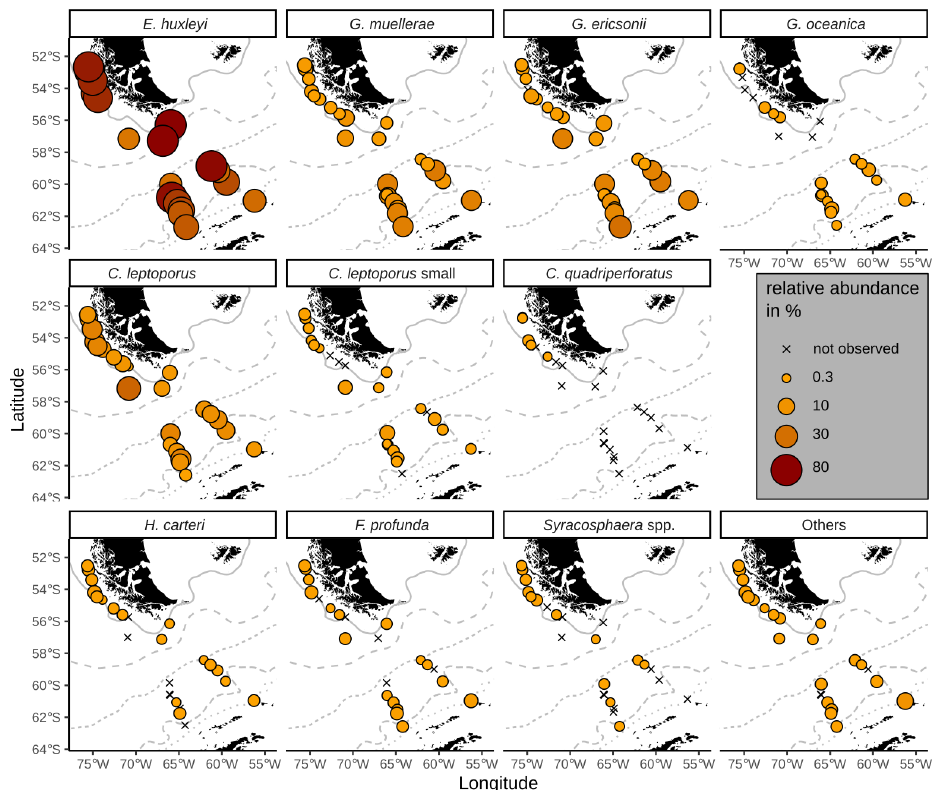
Figure 4. Relative abundances of relevant species in the surface sediments. ACC fronts from north to south: NB (Northern Boundary), SAF (Subantarctic Front), PF (Polar Front), SACCF (Southern ACC Front) and SB (Southern